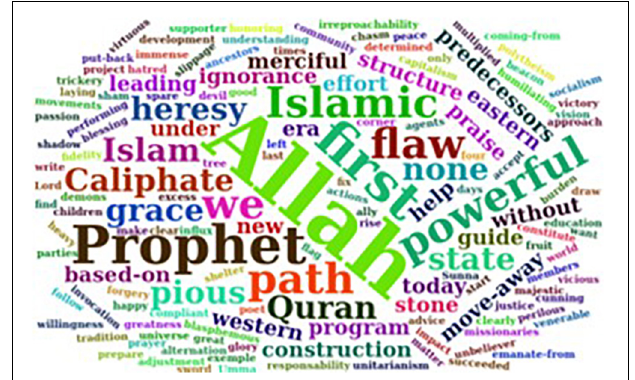
FIGURE 3 | Words clouds about general